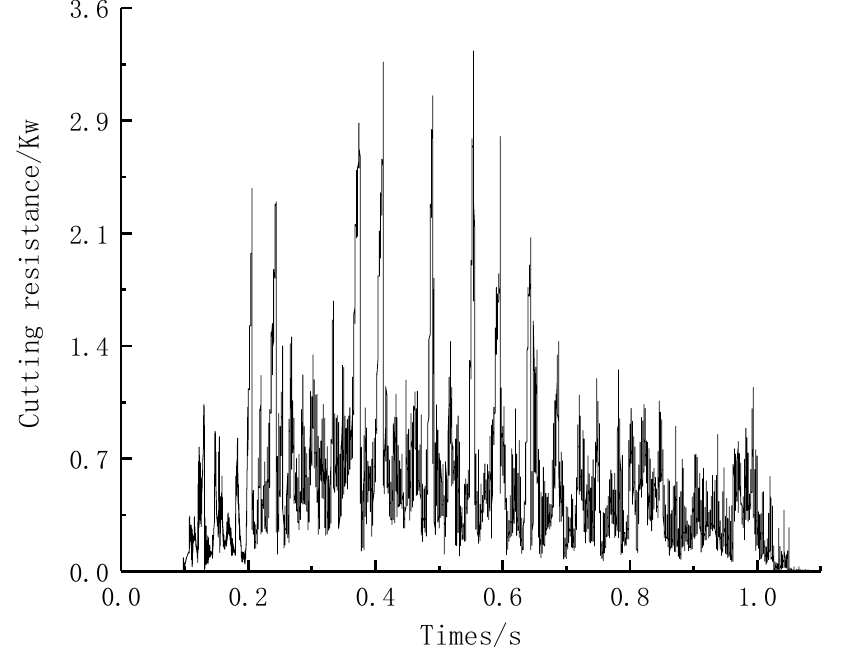
Figure 10. Cutting resistance curve.